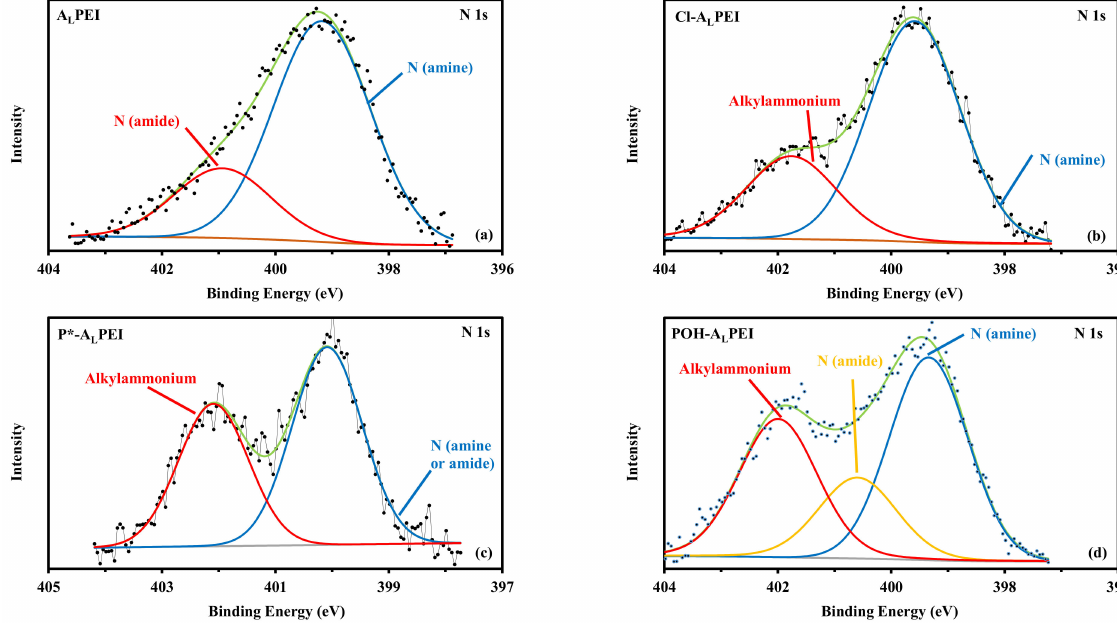
Figure 6. HRES XPS N 1 s core level spectra for A L PEI ( a ), Cl-A L PEI ( b ), P*-A L PEI ( c ) and POH-A L PEI ( d